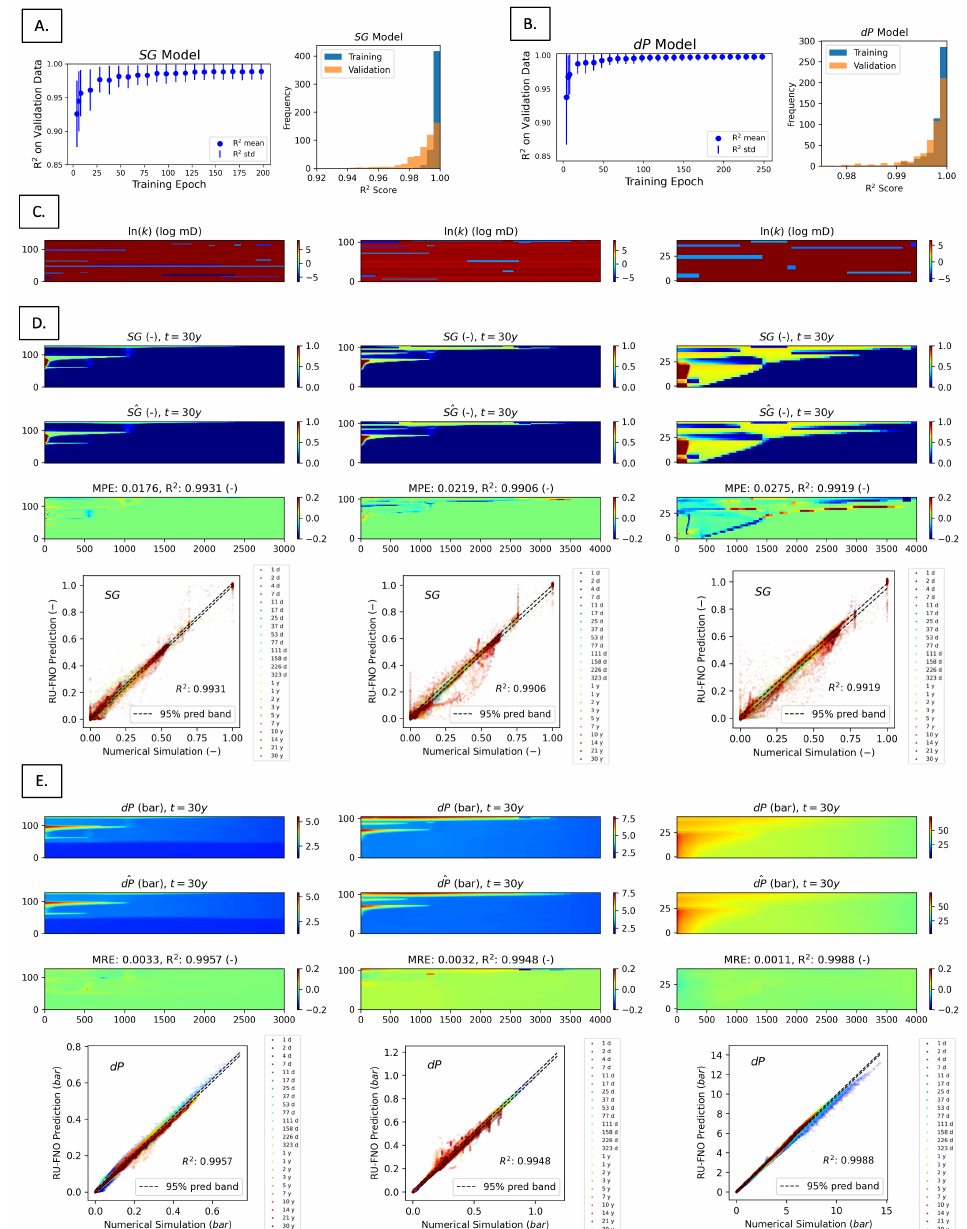
Figure 2. The evolution of the R 2 scores on the validation dataset of the ( A ) gas saturation and ( B ) pressure buildup models during their respective training processes, as well as histograms of the R 2 score for predictions of each data sample. For the former, data points are shown for every other epoch from Epoch 2 to Epoch 10 and, then, subsequently in increments of 10 epochs. The untrained model (i.e., at Epoch 0) for both the SG and dP cases has a validation R 2 of roughly zero. ( C ) The permeability data of three examples from the validation dataset. Each column is a different data sample. ( D ) Examples of predictions from the gas saturation model of the samples in the validation dataset. The rows illustrate the permeability field, the real gas saturation, the predicted gas saturation, and the absolute error of the prediction. The mean plume error and field R 2 of the prediction are listed in the third row of plots for reference. The final row contains scatter plots comparing the real and predicted value of gas saturation for each grid cell in the sample. Cooler colors correspond to earlier times, and warmer colors correspond to later times. ( E ) Examples of predictions from the pressure buildup model of samples in the validation dataset. The mean relative error and field R 2 of the prediction are listed in the third row of plots. Scatter plots of real and predicted pressure buildup are shown in the final